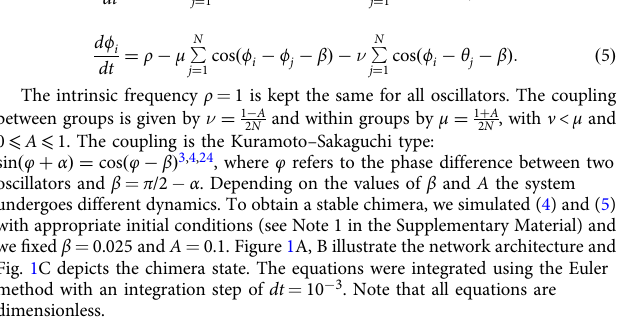
Our work shows that chimeras can emerge on the macroscale of a network as a result of interactions between the nodes without the necessity of high-order couplings (such as non-pairwise interac- tions, multilayer interactions, or time-varying interactions 53 ) and without using a speci fi c coupling or model. We demonstrated that this result is robust to different biological constraints such as the